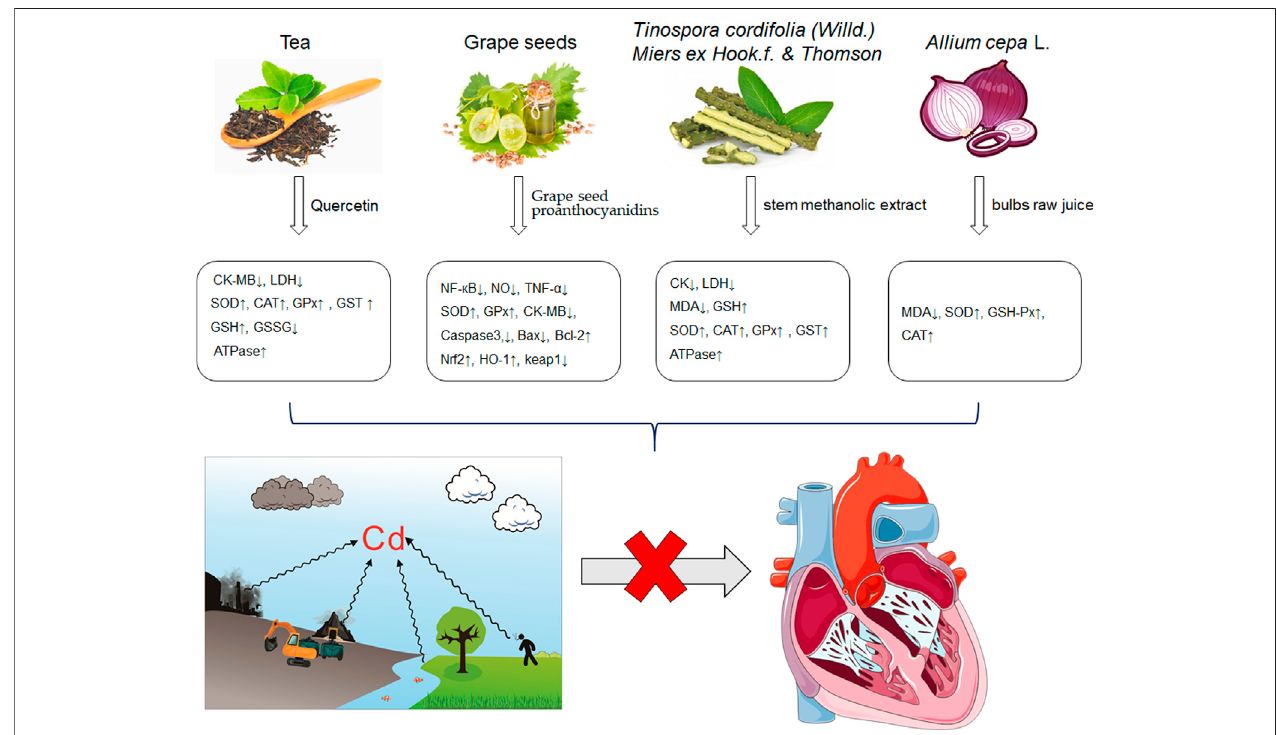
FIGURE1| Thecadmium exposureroutes and protectivemechanisms ofnatural productsagainstcadmium-induced cardiotoxicity.CK-MB, creatinekinase-MB; LDH, Lactic dehydrogenase; SOD, Superoxide dismutase; CAT, catalase; GPx, Glutathione peroxidase; GST, Glutathione S-Transferase; GSH, glutathione; NF- l B, nuclear factor- l B; NO, nitric oxide; TNF- α , tumor necrosis factor- α ; Nrf2, NF-E2-related factor 2; HO-1, heme oxygenase-1; MDA, Malondialdehyde.